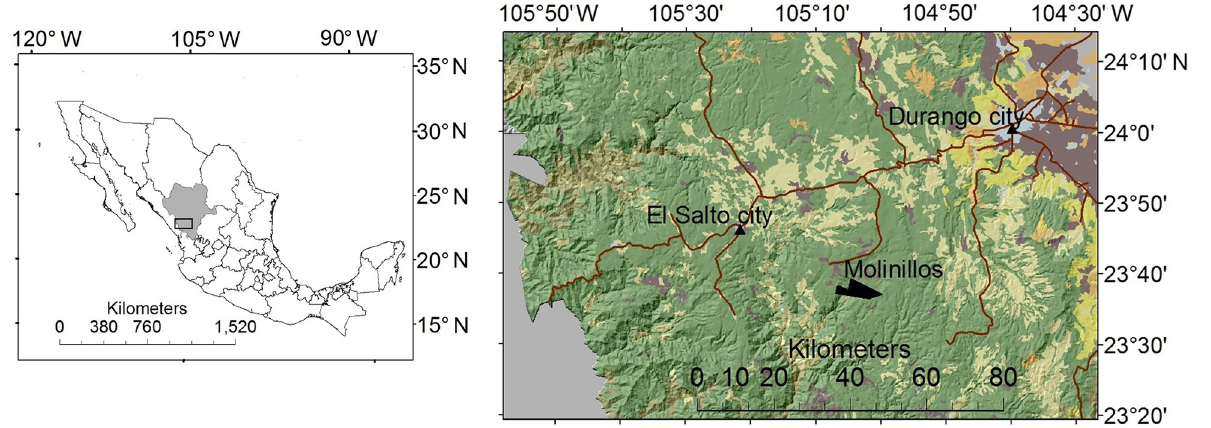
Fig 1. Location of the 2,866-ha study area in the state of Durango, Mexico. The ownership is called Molinillos.